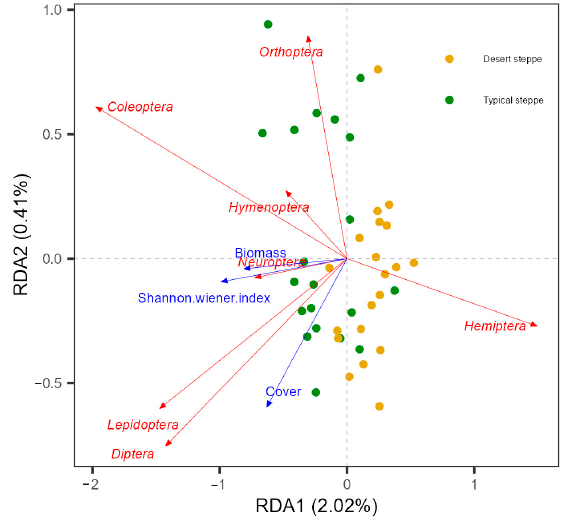
Figure 7. Insect taxonomic composition (orders) in relation to vegetation variables based on redundancy analysis (RDA). Significant vegetation variables are shown (inflation factor < 20, p < 0.05).